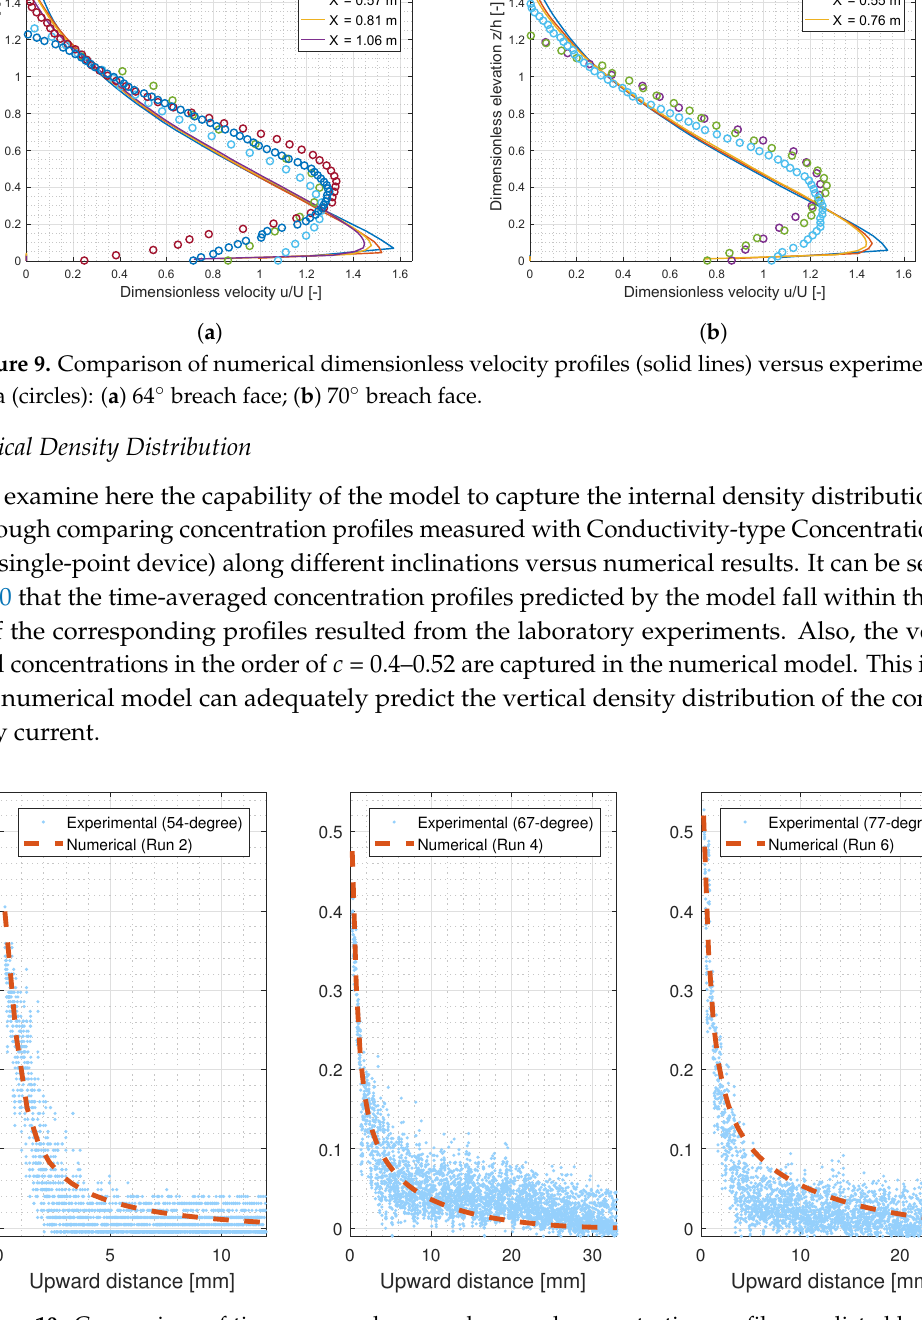
Figure 10. Comparison of time-averaged, upward, normal concentration profiles predicted by the present model against the corresponding experimental results; 54 ◦ ( left ), 67 ◦ ( middle ), and 77 ◦ breach face ( right